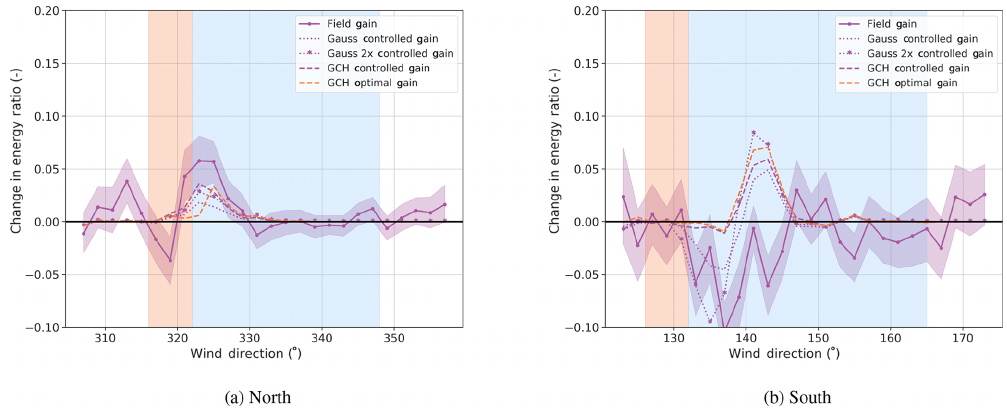
Figure 13. Change in the energy ratio of the third turbine in the row for the North Campaign (T4) and the South Campaign (T2).